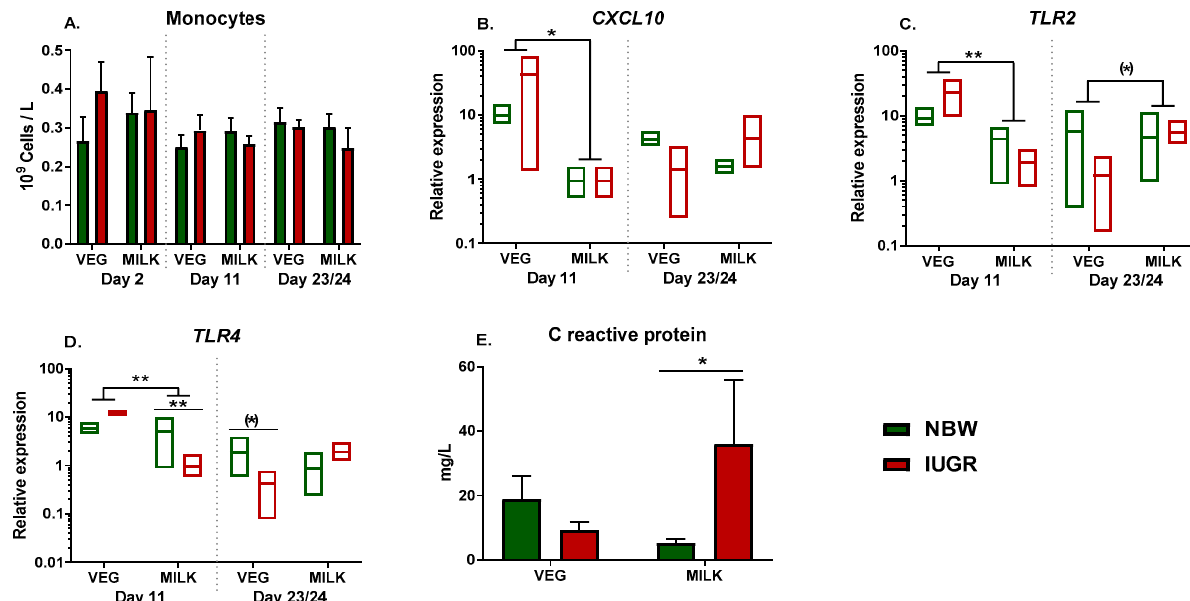
Figure 2. Development of monocyte counts and gene expression of innate immune markers in animals fed either vegetable (VEG, n = 6–18) or milk fat (MILK, n = 7–18) further stratified into normal birthweight (NBW, n = 7–18) or intrauterine growth restricted (IUGR, n = 6–18) animals. ( A ) Monocyte counts; ( B – D ) Expression of CXCL10 , TLR2 , and TLR4 in whole blood stimulated with Staphylococcus epidermidis , shown as relative gene expression; ( E ) Level of CRP in plasma on day 23/24. ( A , E ) are presented as means with corresponding standard error, ( B – D ) are presented as range plots with corresponding medians. **: P < 0.01, *: P < 0.05, (*): P < 0.1.